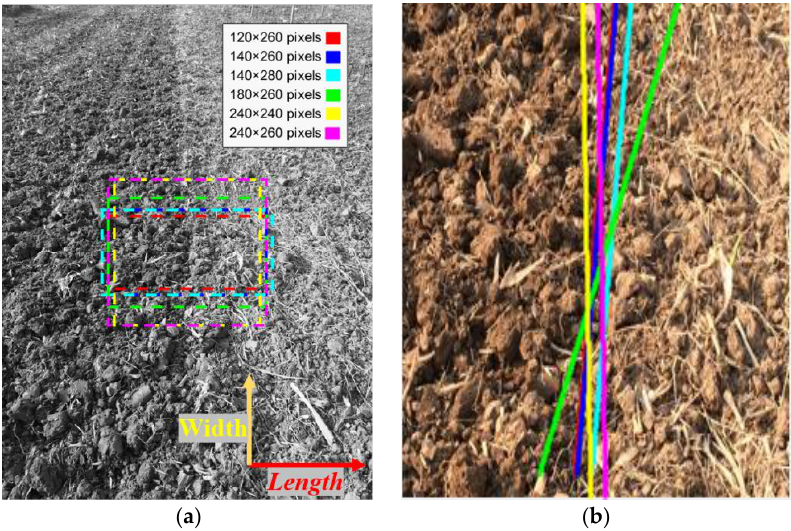
Figure 17. Different templates: ( a ) rectangular frame selection; ( b ) navigation line extraction result.